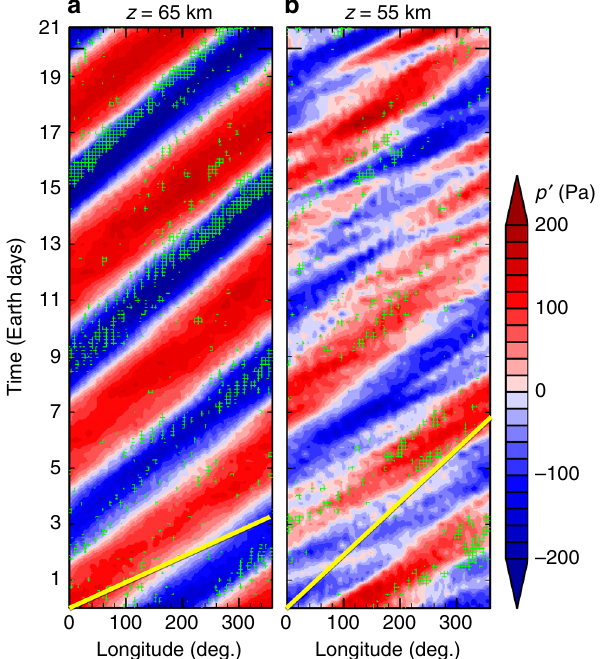
Fig. 6 Longitude-time cross-sections (Hovmöller diagram) of the pressure anomaly (red-blue shading) at the latitude of − 35 deg. for ZS0. The altitudes are a 65 km and b 55 km. Green hatching shows regions of downward fl ow stronger than − 0.03 m s − 1 . The yellow solid line shows the zonal mean zonal velocity at each